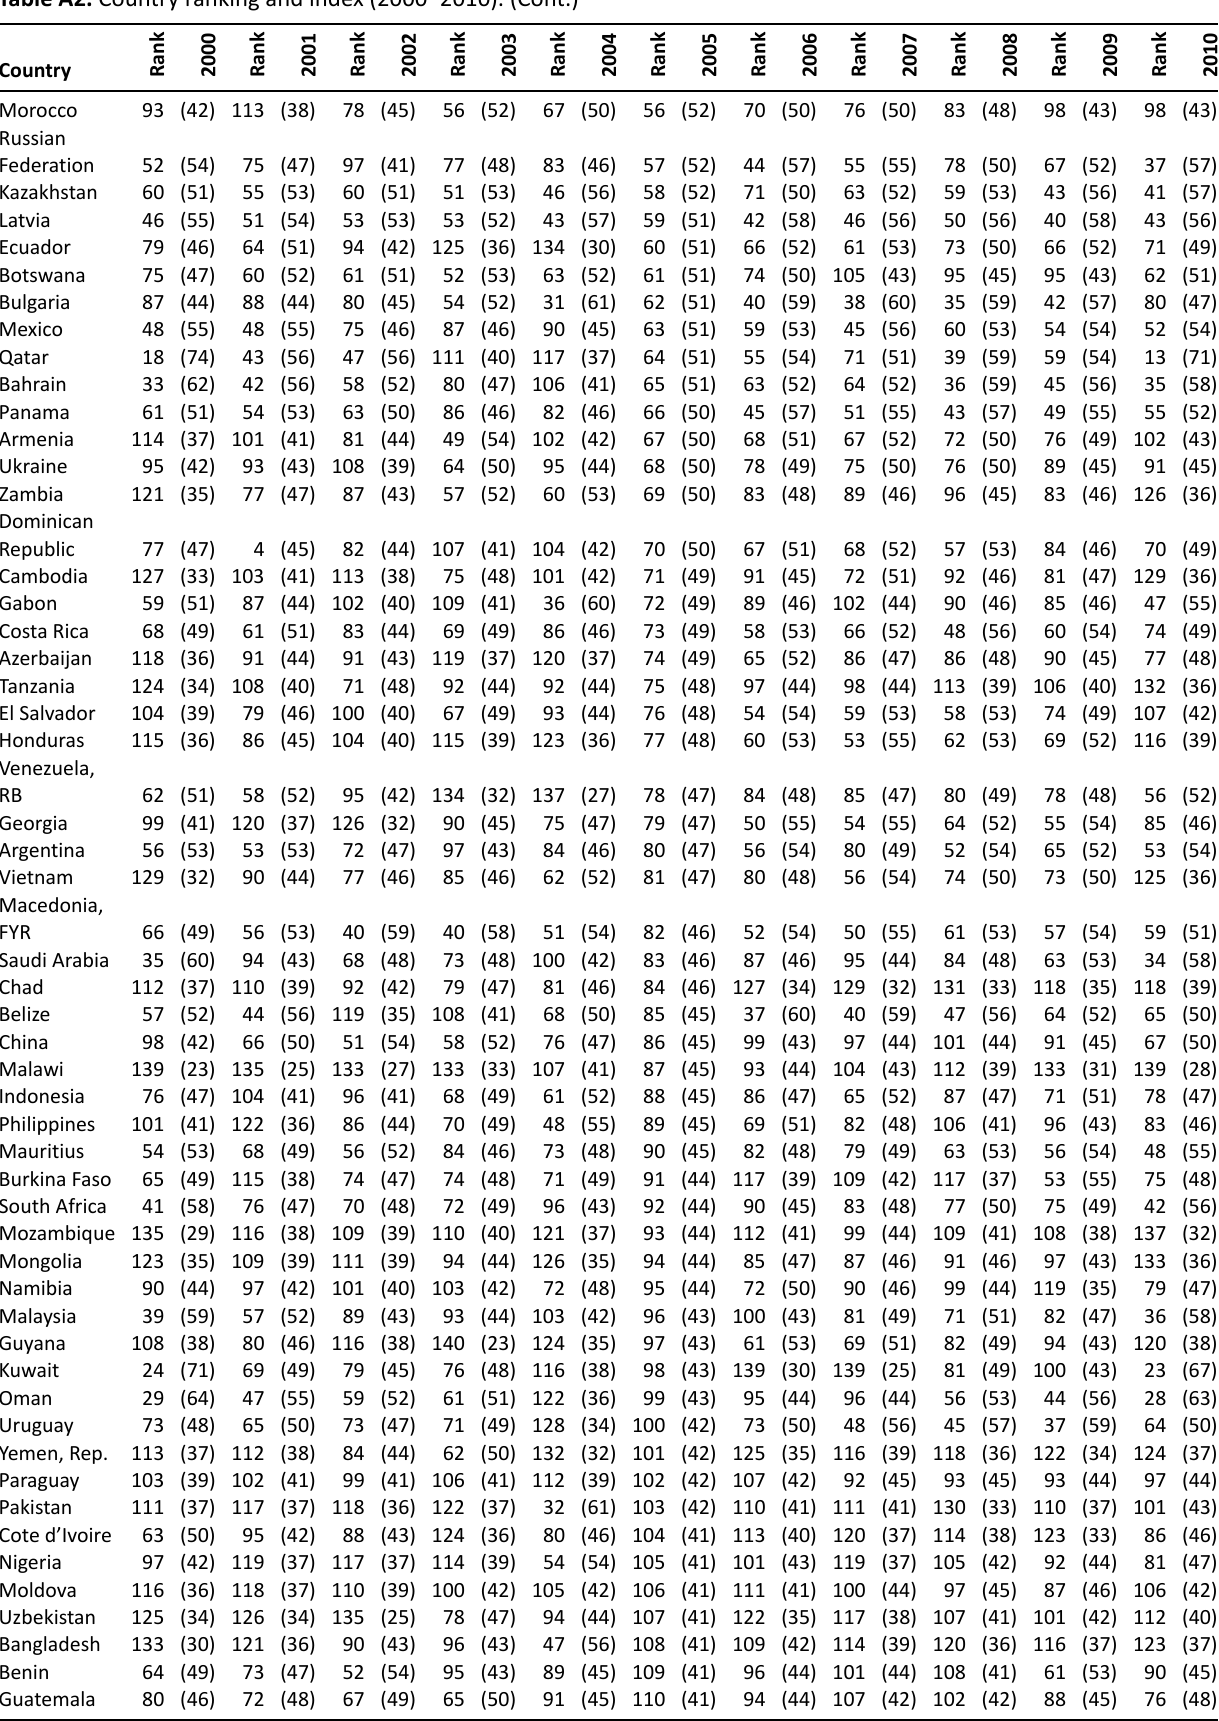
Table A2. Country ranking and index (2000–2010).